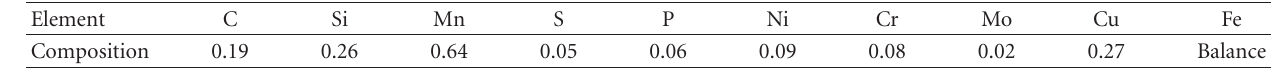
Table 1: Chemical composition of the mild steel.